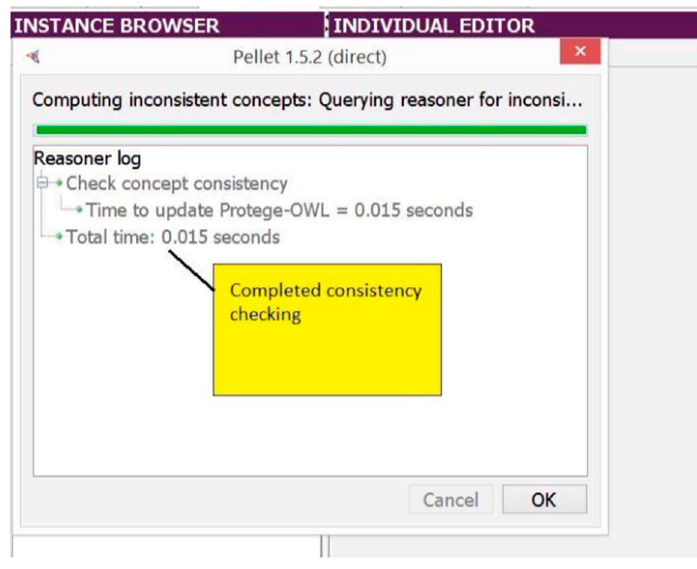
Figure 10. Consistency checking using Pellet reasoner.